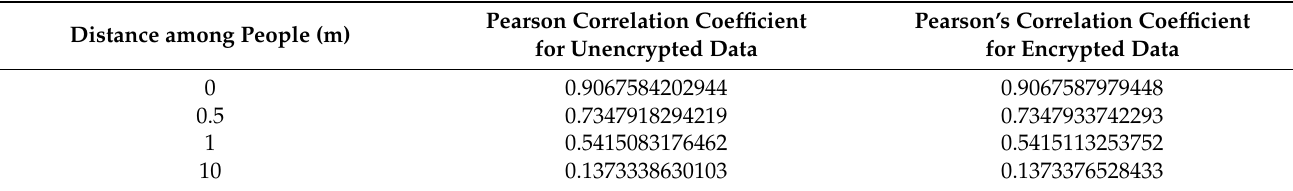
Table 3. Similarity calculation results (Partial results). Distance among People